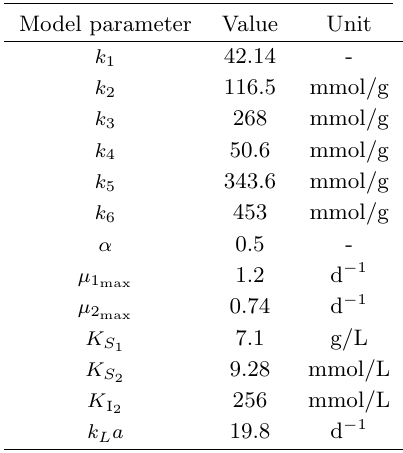
Table 1: AM2 model parameters based on Bernard et al. (2001) Model parameter